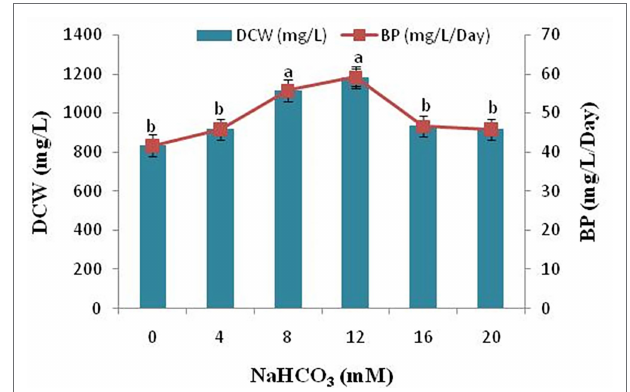
FIGURE 6 | Effect of different sodium bicarbonate concentrations on biomass yield and lipid content of microalga Scenedesmus sp. BHU1. Bars are mean ± SE of three replicates. Bars adhered with different alphabets (a and b) are statistically significant at p < 0.05 (Tukey’s-b post hoc